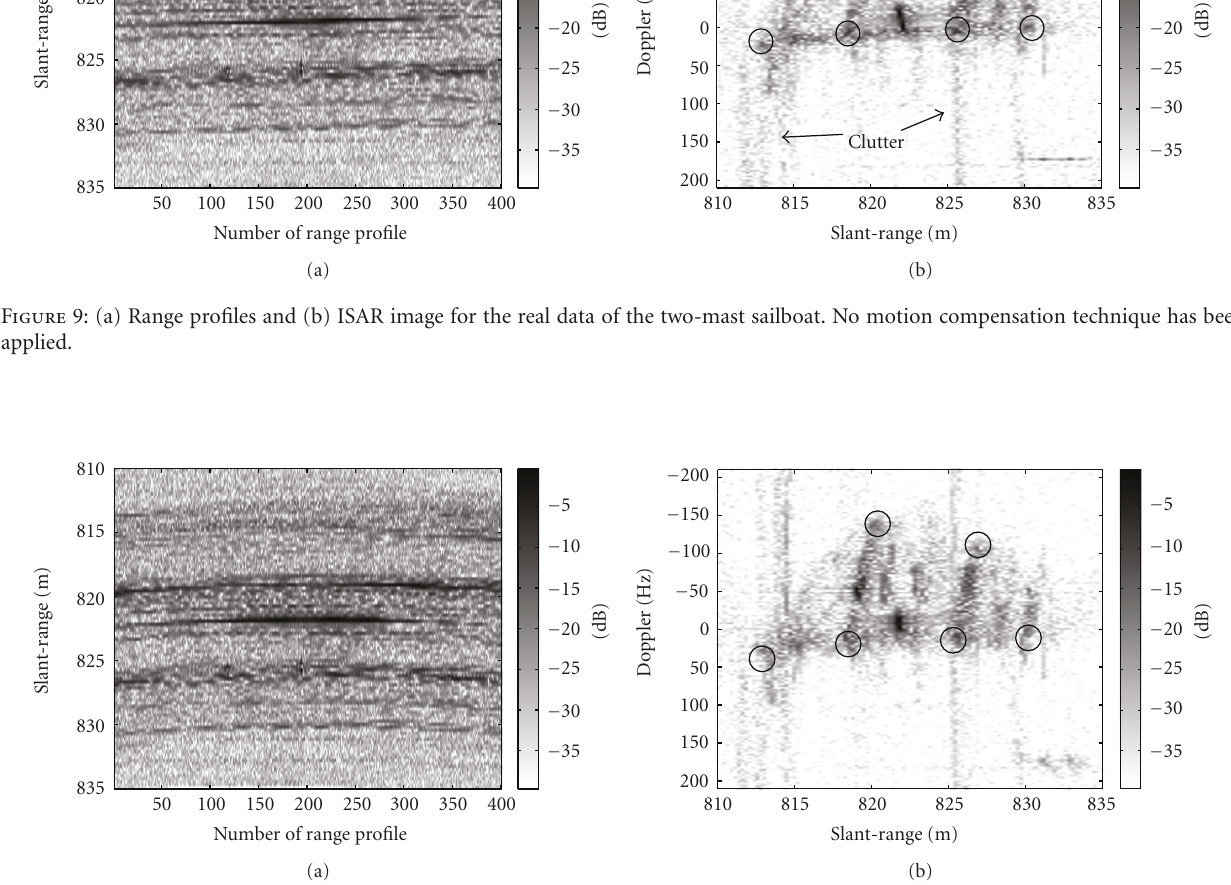
Figure 10: (a) Range profiles and (b) ISAR image for the real data of the two-mast sailboat after applying the centroid tracking method.